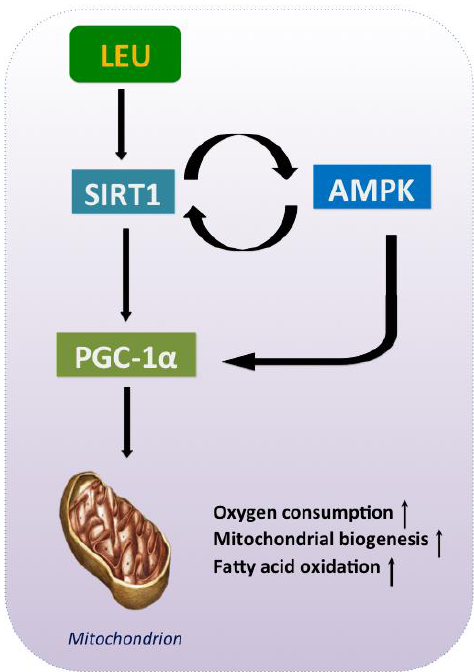
Figure 3. The SIRT1–AMPK–PGC-1α axis is involved in the leucine regulation in energy metabolism.